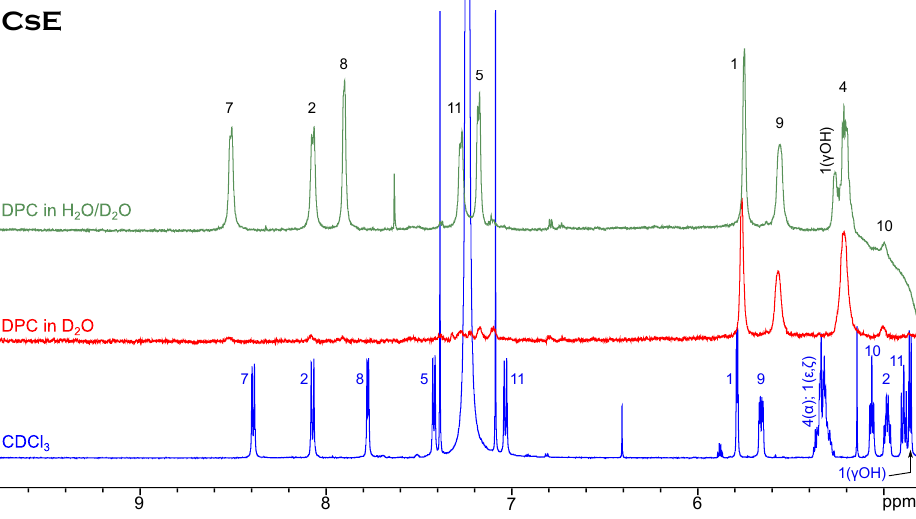
Figure 3. 1 H NMR spectrum of CsE in chloroform compared to spectra in micellar solution. Chemical shifts depend on several factors, including the conformation of the studied molecule, surrounding molecules and the presence of hydrogen bonds. Scalar